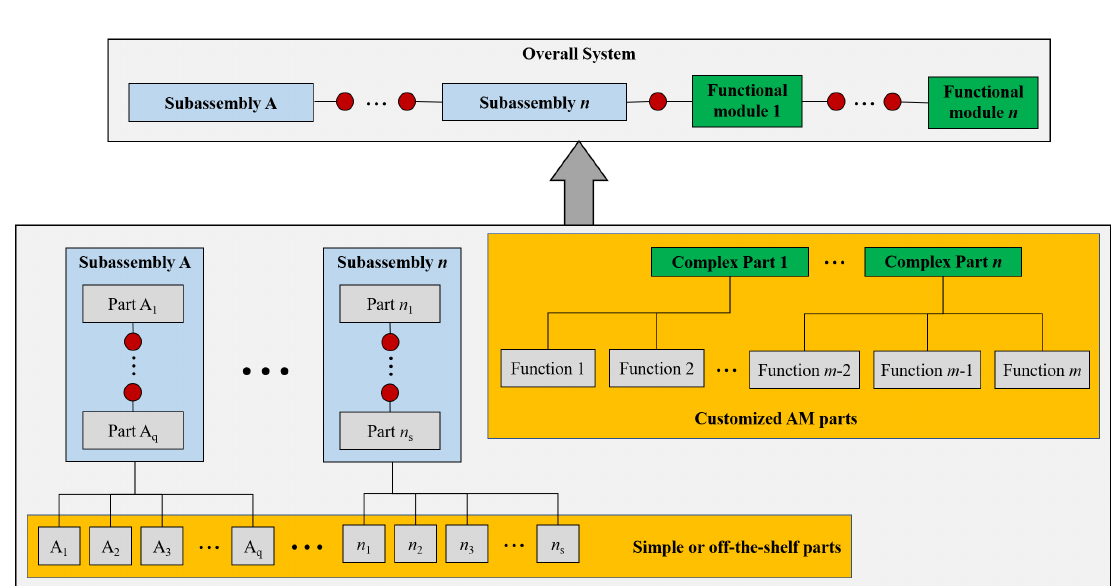
Figure 6. Some aspects to consider when evaluating the feasibility of DFAM.